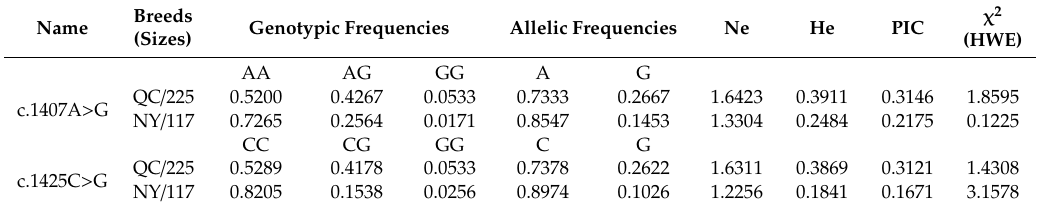
Table 2. Genotyping and population genetic analysis in RET .